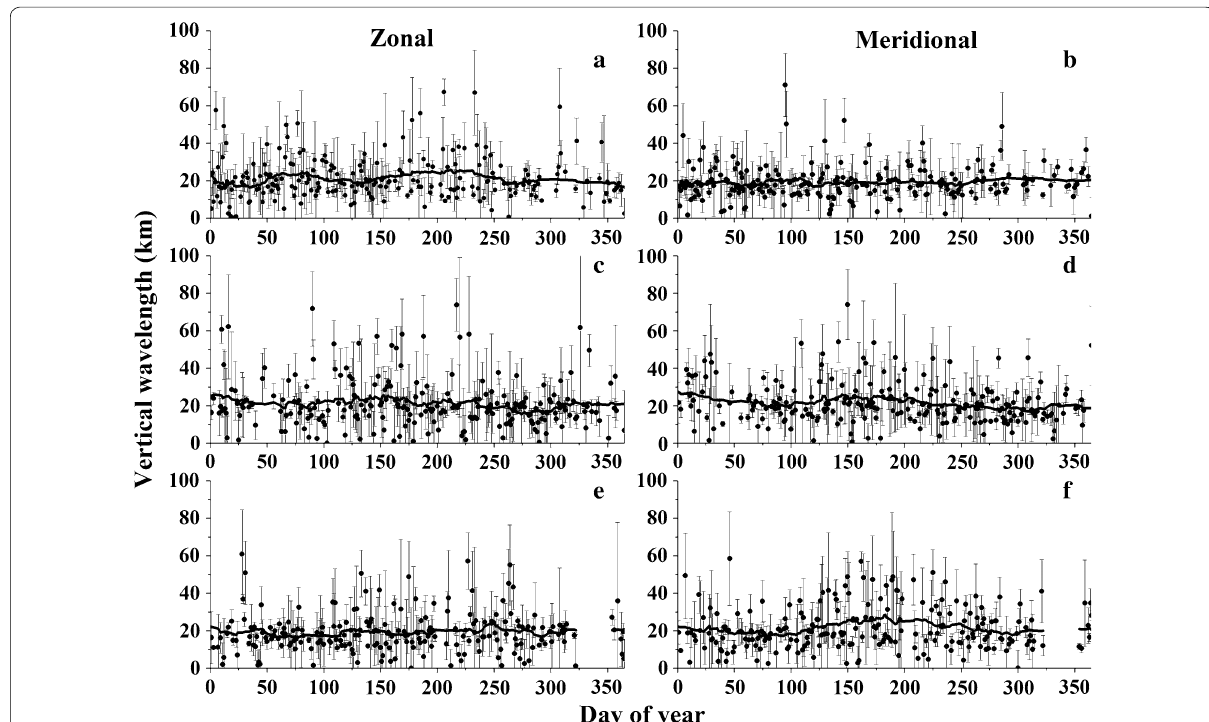
Fig. 10 Daily vertical wavelength of the QDT over the year for the a zonal wind at CA, b meridional wind at CA, c zonal wind at CP, d meridional wind at CP, e zonal wind at SM and f meridional wind at SM